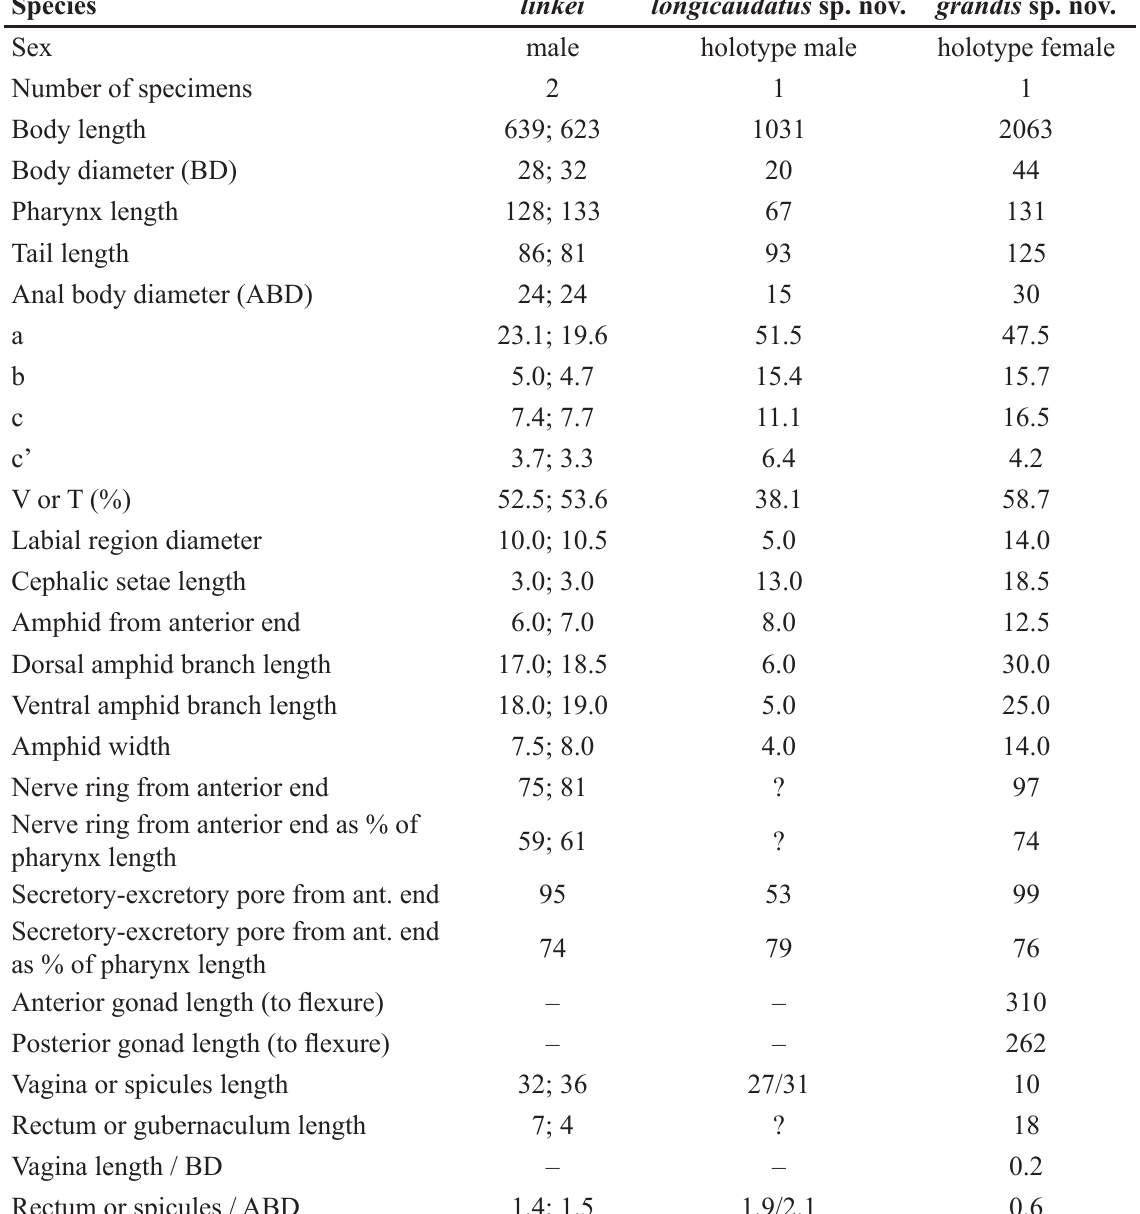
Table 6. Measurements (in µm) of Diplopeltoides linkei Jensen, 1991, Diplopeltoides longicaudatus sp. nov. and Diplopeltoides grandis sp. nov. (for D. linkei : each male individual measurement separated with a semicolon; “?” indicates that the character can not be observed or